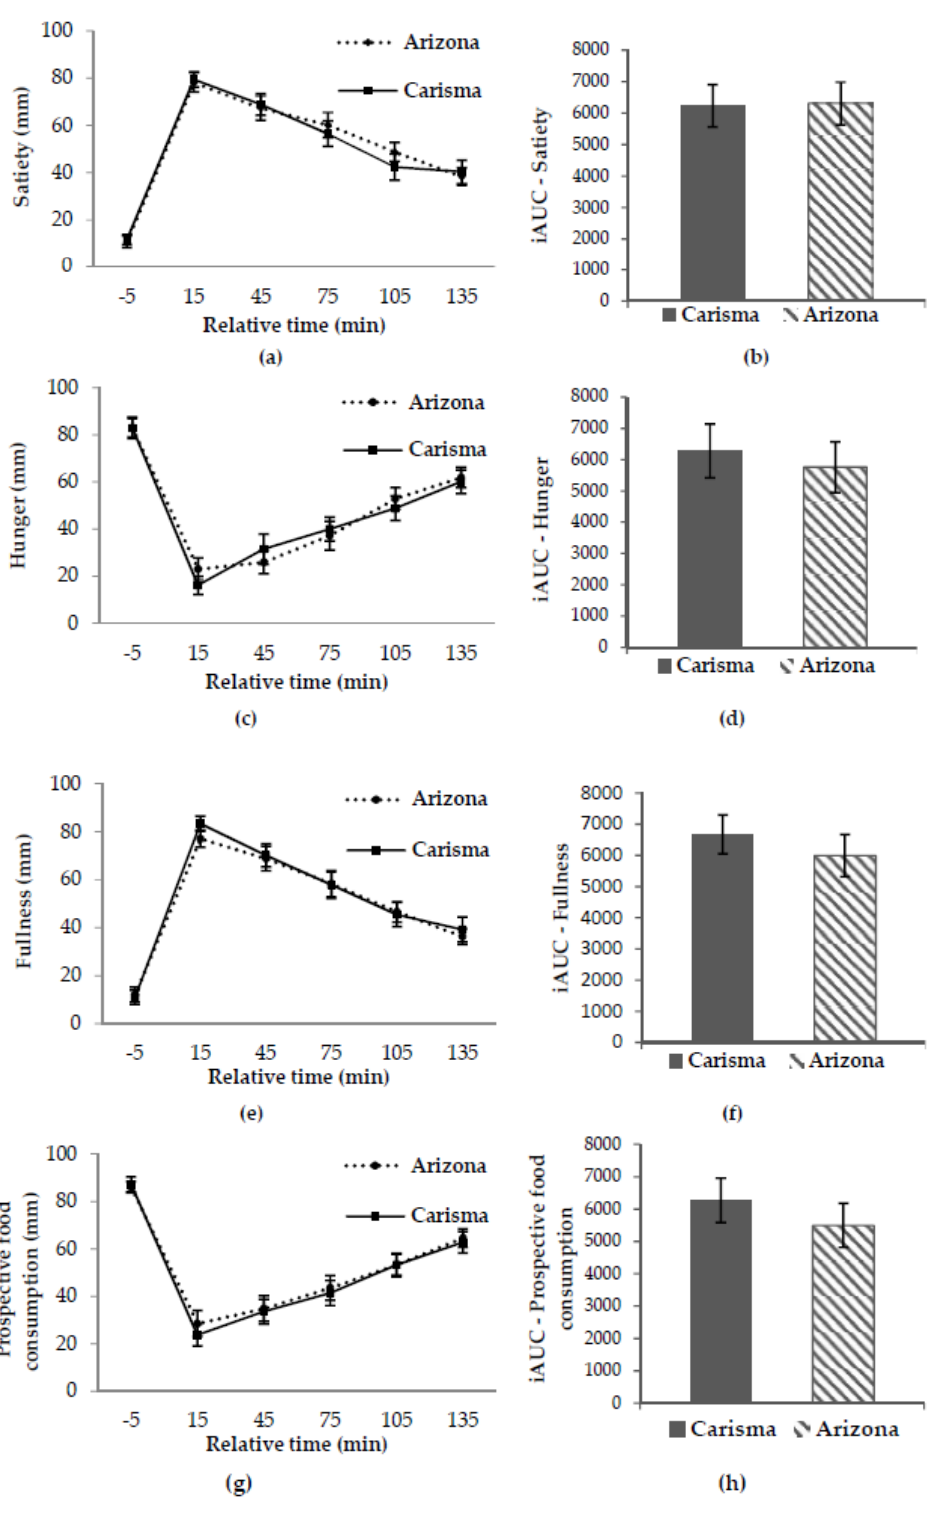
Figure. 2 Unadjusted mean curves for satiety (a) , hunger (c) , fullness (e) and prospective food Figure 2. Unadjusted mean curves for satiety ( a ), hunger ( c ), fullness ( e ) and prospective food consumption (g) and corresponding incremental areas under/over the curves (iAUC/iAOC) (b) , (d) , consumption ( g ) and corresponding incremental areas under/over the curves (iAUC/iAOC) ( b ), (f) and (h) . Data are shown as means ± SE. All p > 0.05 (adjusted p-value). Carisma ® (low GI) and ( d ), ( f ) and ( h ). Data are shown as means ± SE. All p > 0.05 (adjusted p -value). Carisma ® (low GI) and Arizona (high GI). SE, standard error; GI, glycaemic index. Arizona (high GI). SE, standard error; GI, glycaemic